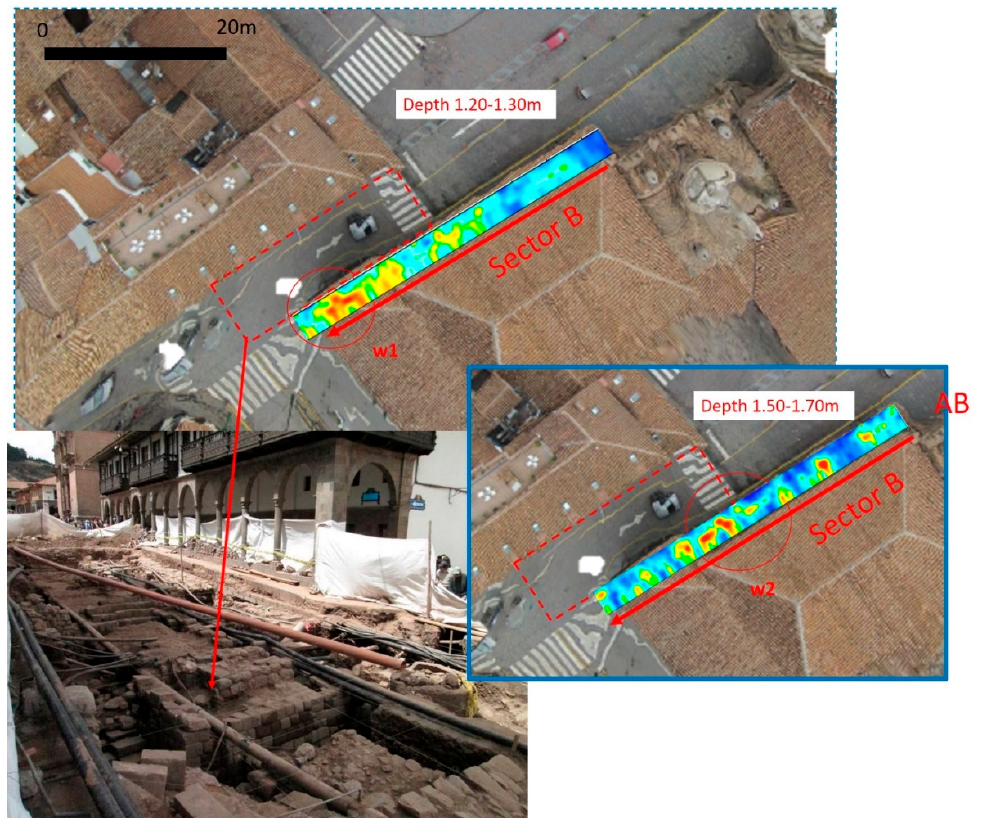
Figure 16. Comparison between the GPR and excavation results.